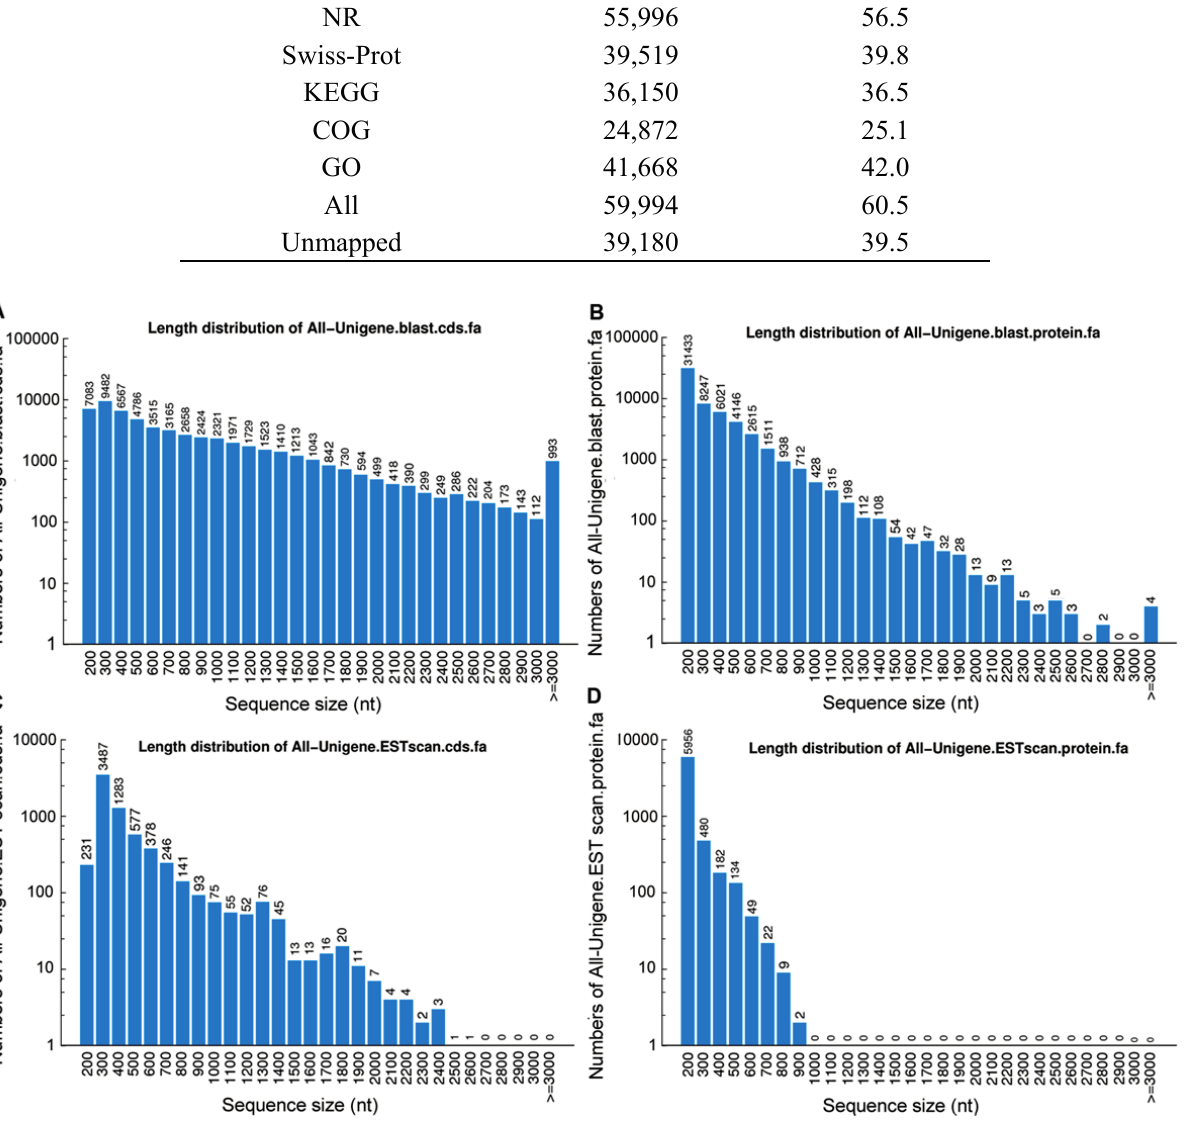
Figure 3. Length distributions of the protein-coding region predictions (CDSs) ( A − D ). The length distributions of CDSs using BLASTx ( A ); the length distributions of proteins using BLASTx ( B ); the length distributions of CDSs using ESTscan ( C ); the length distributions of proteins using ESTscan ( D